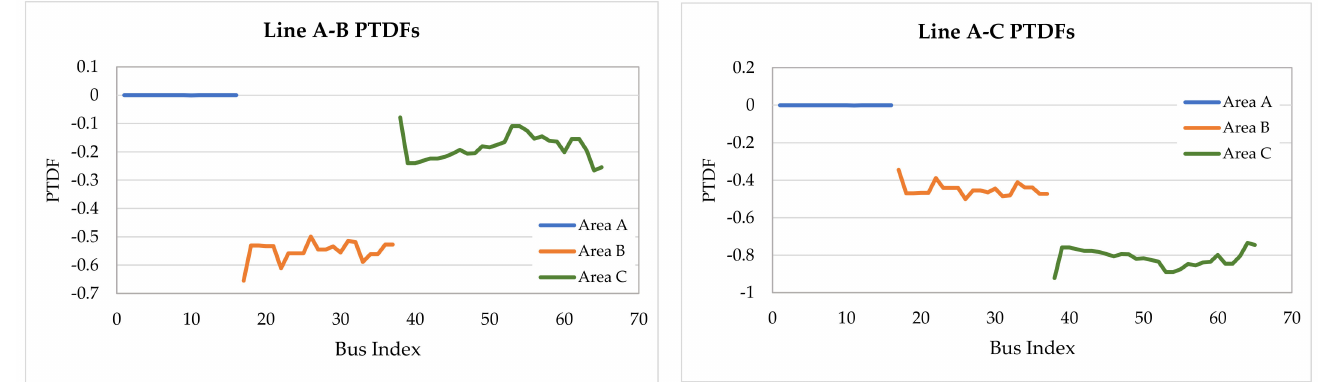
Figure 8. PTDFs of lines A-B and A-C with respect to all the buses of the